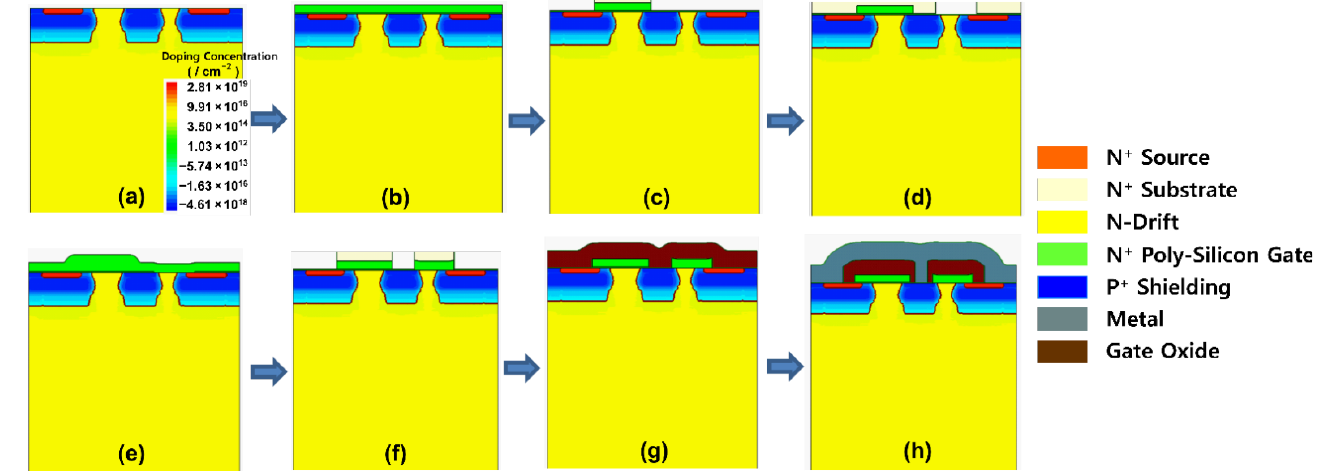
Figure 13. Proposed fabrication process of CIMCD – MOSFET. ( a ) The drift region is formed through epitaxyial growth on an N+ SiC substrate, and P+ shielding, P base, and N+ source are formed through multi-implantation. ( b ) An oxide film is formed through dry oxidation and doped polysilicon is deposited by CVD. ( c ) Anisotropic polysilicon etching to form a gate region. ( d ) Anisotropic etching of SiO 2 to form a thin oxide film. (Tox 2 ) ( e ) Deposition of polysilicon through CVD. ( f ) Anisotropic etch polysilicon to form a dummy gate. ( g ) Deposition of inter-level dielectric (ILD) oxide through CVD. ( h ) Etching the oxide and metallization.